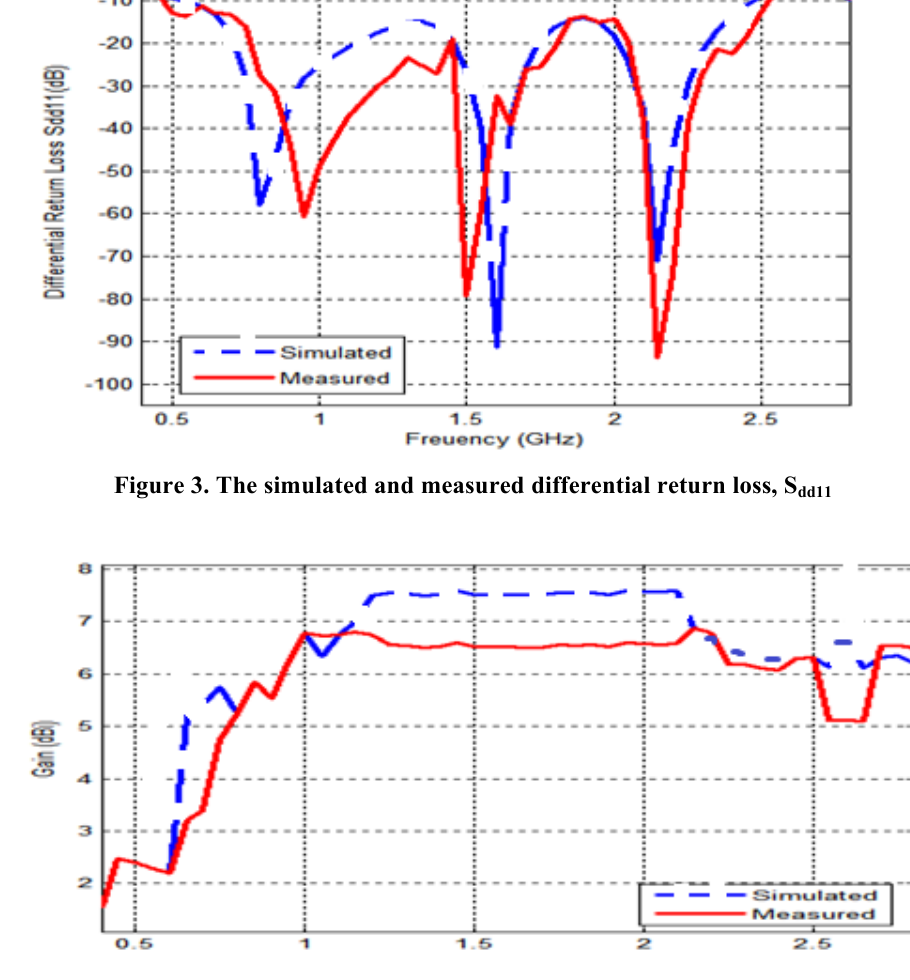
Figure 4. The simulated and measured gain of proposed antenna